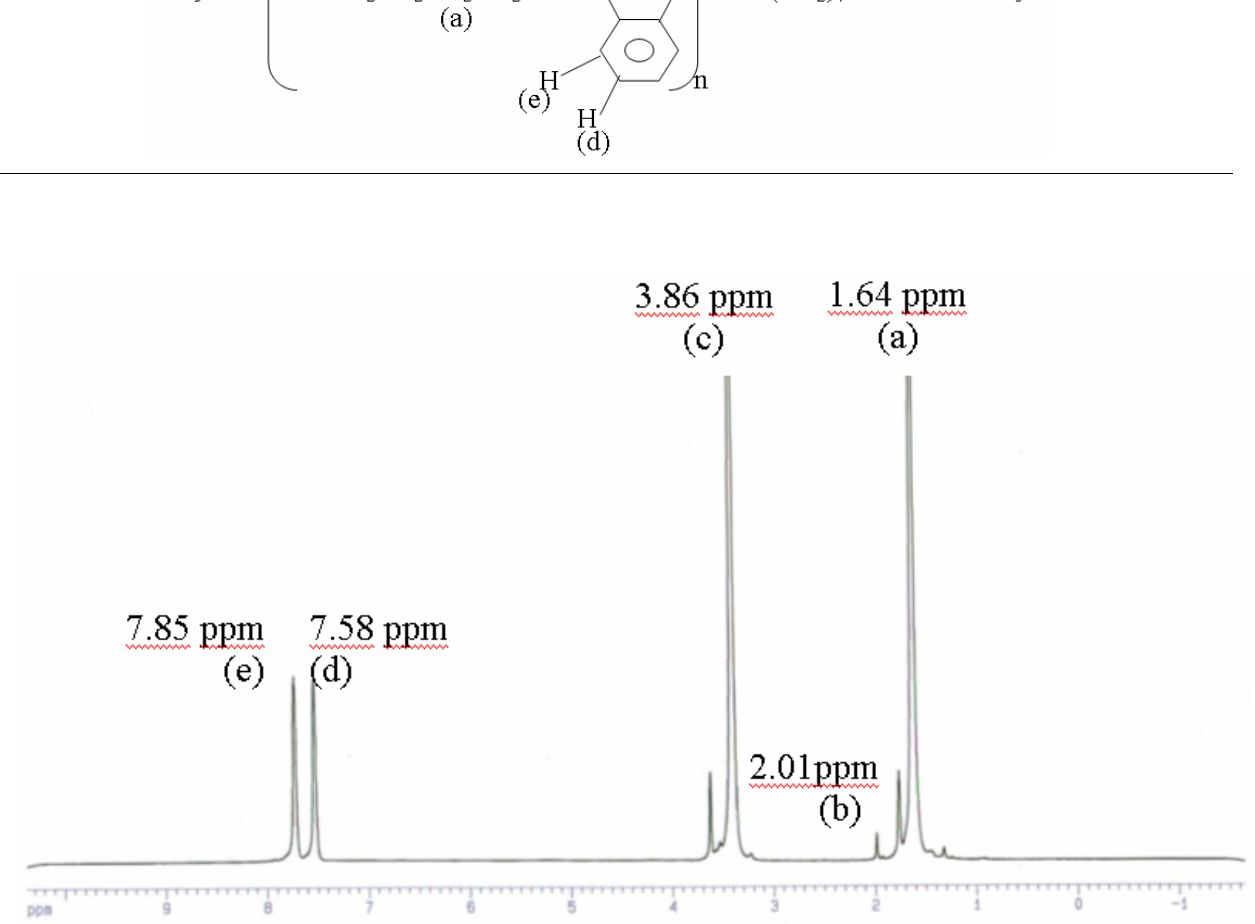
Figure7: 1 H NMR spectra of poly(oxybutylene oxyphthaloyl) product of experiment 2 in table